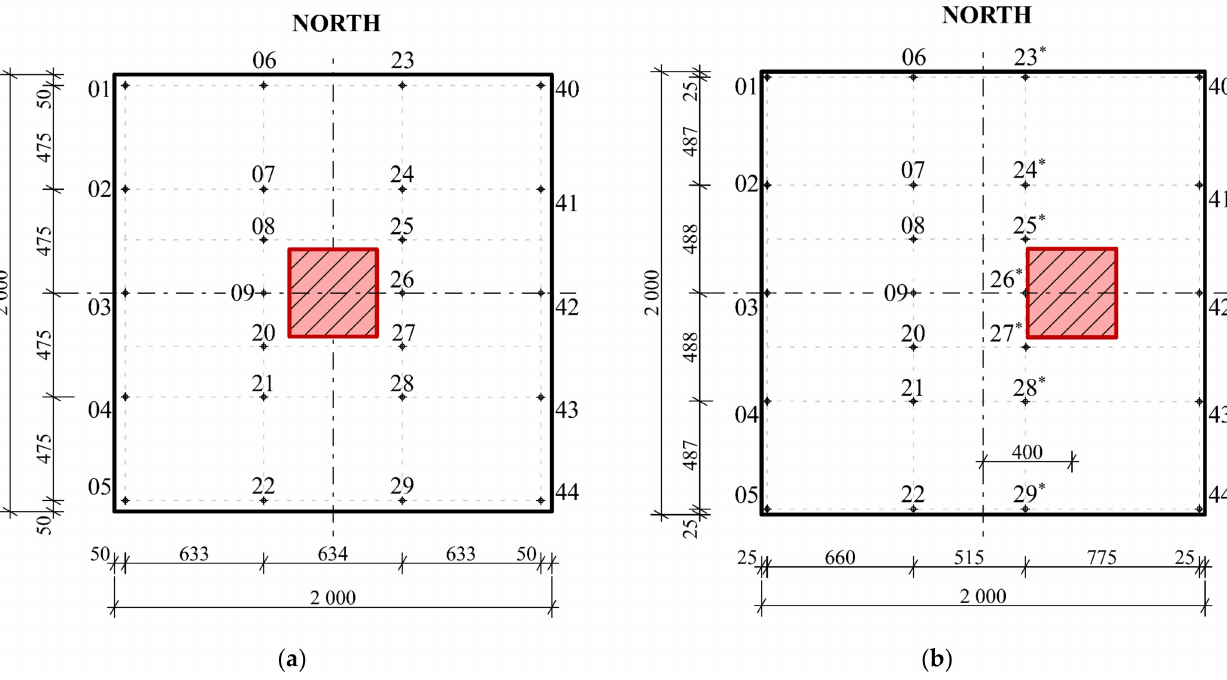
Figure 11. Sensor layout schema: ( a ) centrically loaded slab G10; ( b ) eccentrically loaded slab